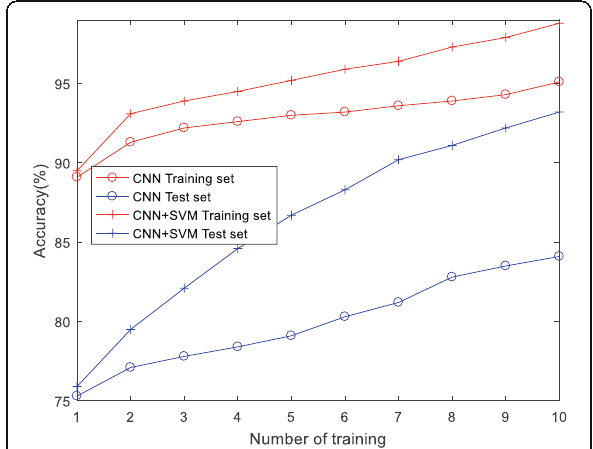
Fig. 7 Comparison of classification performance between CNN and hybrid models